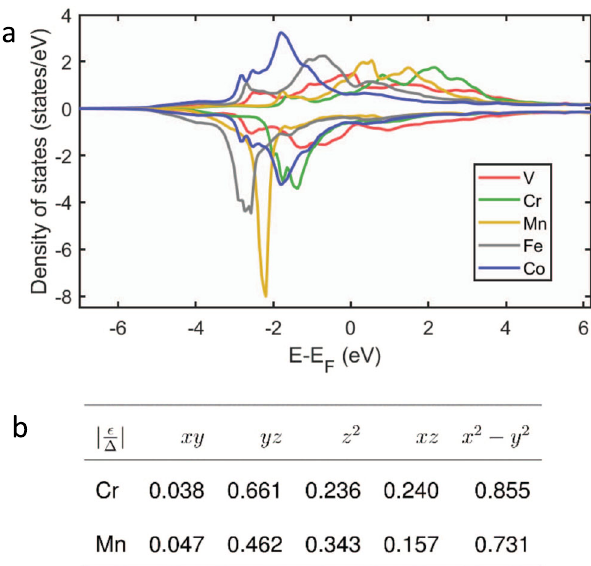
Fig. 4 Local density of states and energies of YSR states. a Spin-resolved electronic structure for V, Cr, Mn, Fe, and Co — upper (lower) panel for minority- (majority-) spin channel. b Theoretically obtained table of orbital- dependent energies of YSR states normalized by the superconducting